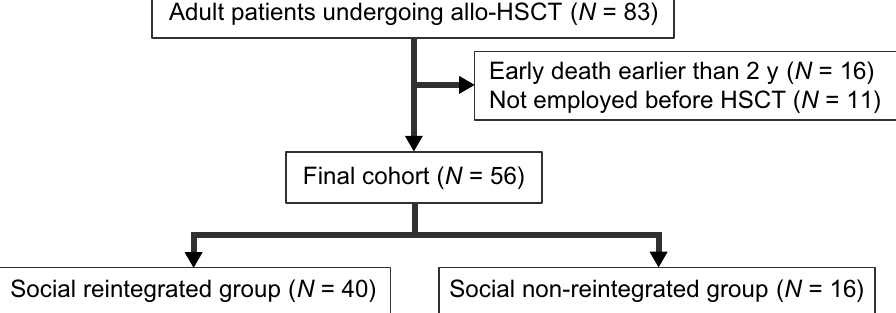
Figure 1. The study flow diagram. The flow diagram of the study cohort is shown. The inclusion and exclusion criteria were compatible with those shown in